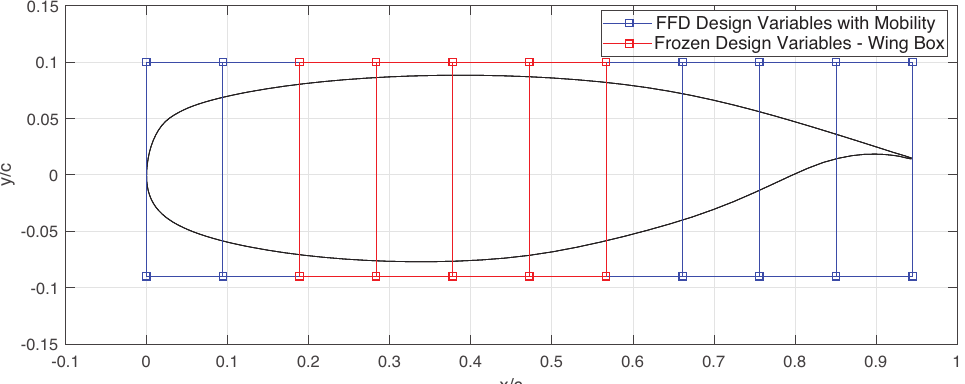
Figure 11. FFD box design variables with virtual wing box and deformable leading and trailing